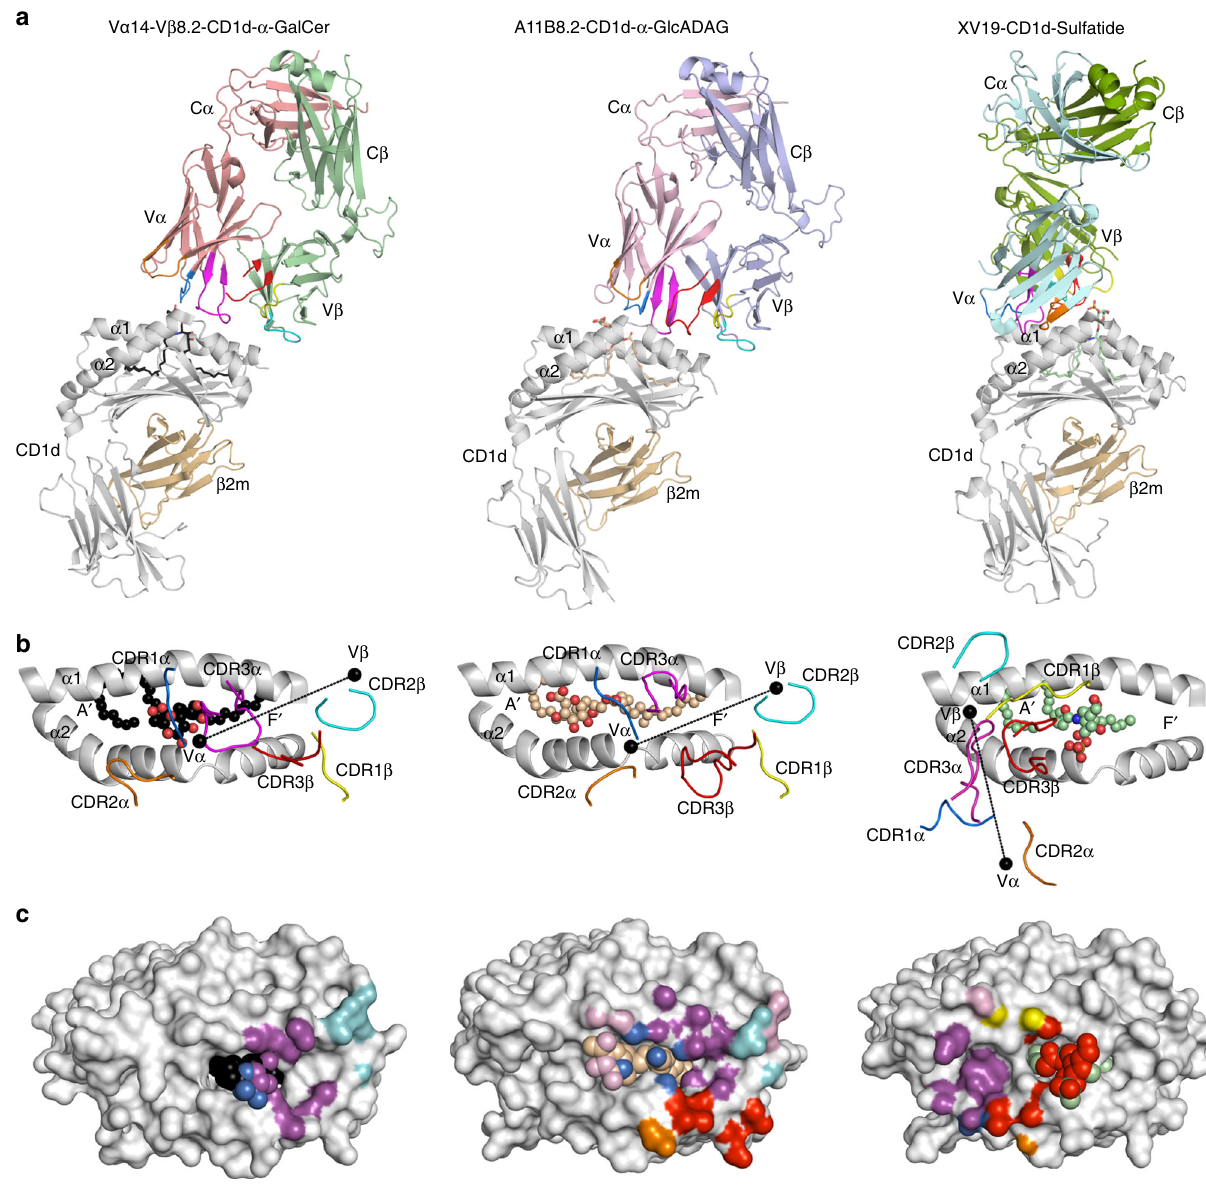
Fig. 4 Overview of the mouse type I, type II XV19, and A11B8.2 NKT TCR ternary complexes. a Cartoon representation of the structure of the mouse type